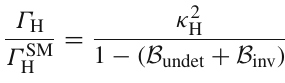
Fig. 9 Summary of the κ -framework model assuming resolved loops and B BSM = 0. The points indicate the best fit values while the thick and thin horizontal bars show the 1 σ and 2 σ CL intervals, respectively. In this model, the ggH and H → γγ loops are resolved in terms of the remaining coupling modifiers. For this model, both positive and negative values of κ W , κ Z , and κ b are considered. Negative values of κ σ W in this model are disfavored by more than 2 Table 7 Best fit values and ± 1 σ uncertainties for the parameters of the κ model in which the loop processes are resolved. The expected uncertainties are given in brackets Parameter Best fit value Uncertainty stat.